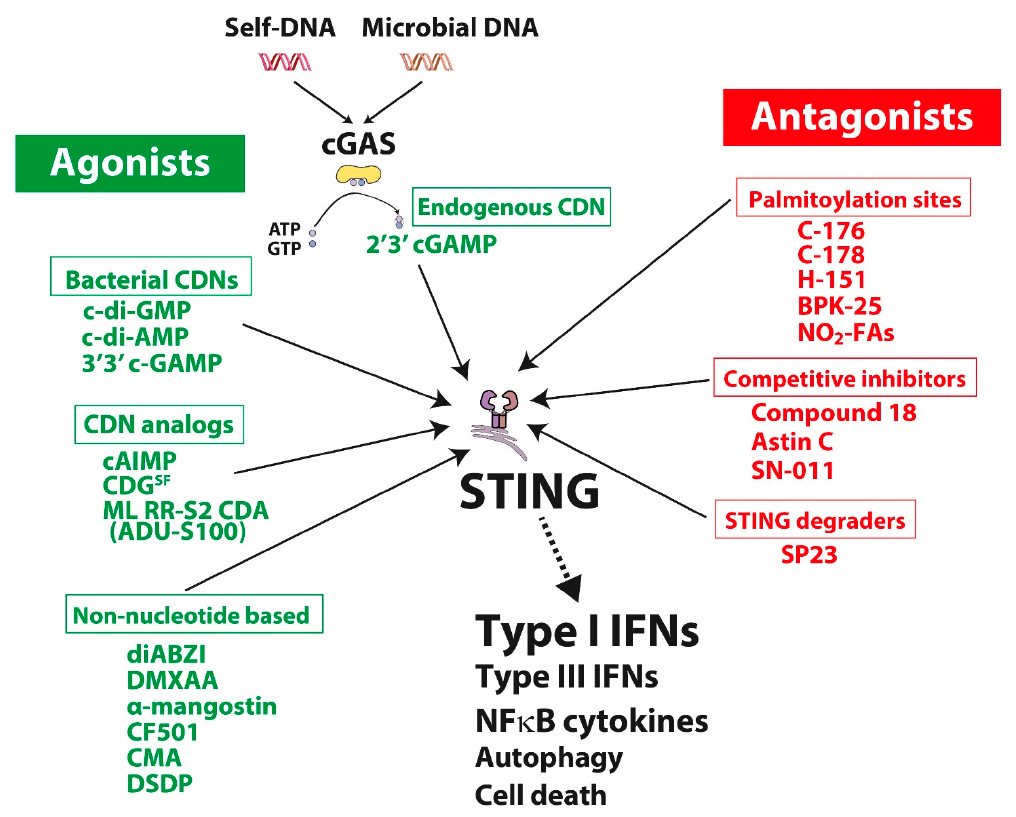
Figure 1. Misplaced self-DNA or microbial DNA in the cytoplasm binds to cGAS producing the cyclic dinucleotide (CDN) 2 ′ ,3 ′ -cyclic GMP-AMP (2 ′ ,3 ′ -cGAMP) from ATP and GTP. cGAMP binds to STING located in the endoplasmic reticulum (ER) membrane, which undergoes a conformational shift inducing a phosphorylation cascade leading to the activation of genes encoding for type I/III IFNs as well as NF- κ B-dependent genes. Activated STING is also directly involved in cellular processes notably autophagy and cell death regulations. Besides 2 ′ ,3 ′ -cGAMP as the endogenous STING activator, other agonists include bacterial CDN as well as synthetic compounds, CDN analogs or non-nucleotide-based molecules. STING inhibitors comprise compounds that target its palmitoylation site, act as competitive inhibitors or promote its degradation.